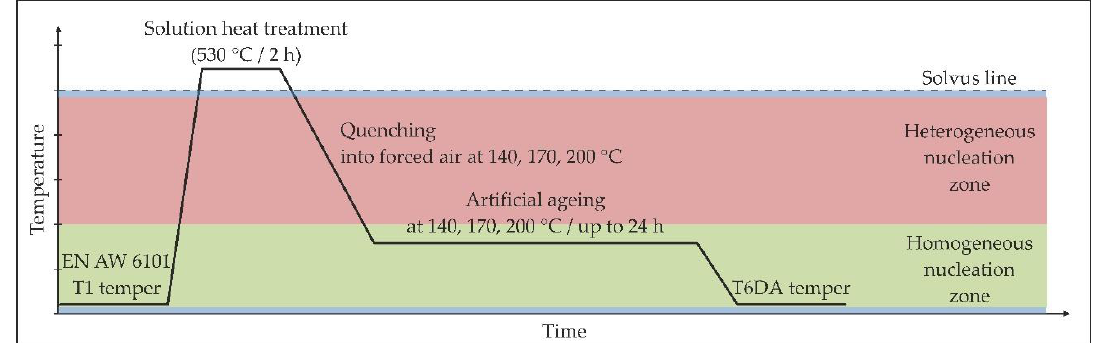
Figure 3. Temperature-time scheme of the direct ageing procedure (T6DA).